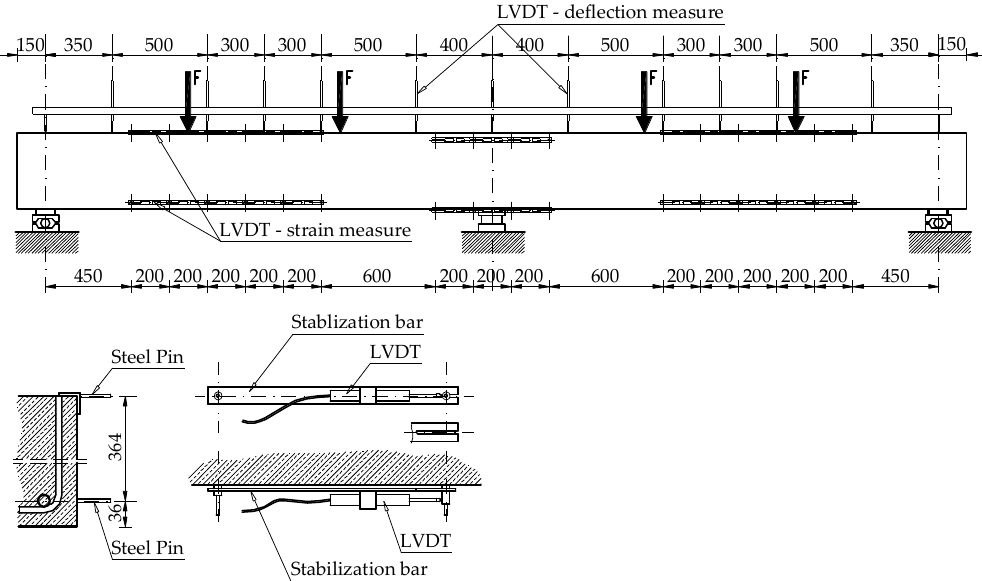
Figure 5. Specimen instrumentation scheme.